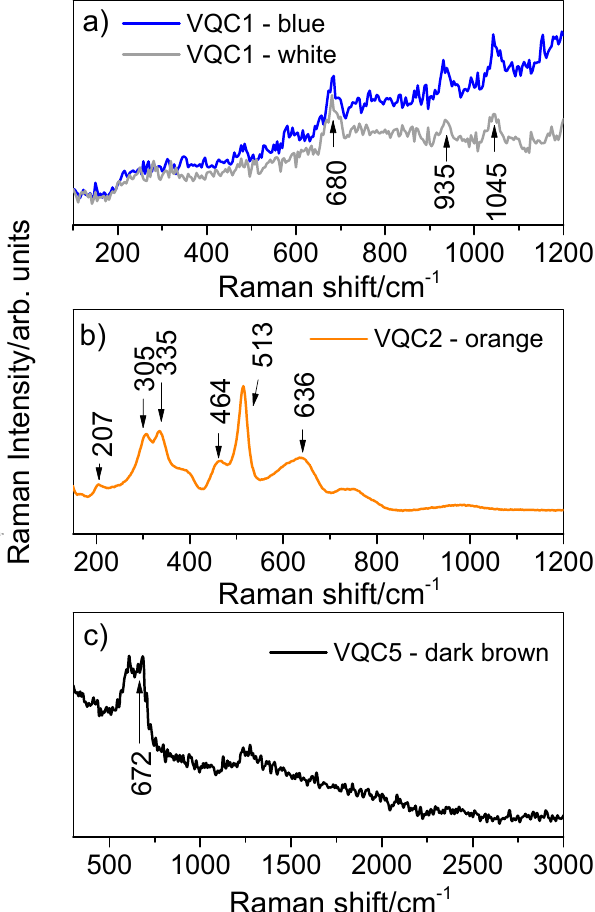
Figure 5. Representative Raman spectra recorded on ( a ) blue and white colouring areas of the VQC1 sample (excitation wavelength of 364 nm), ( b ) orange area of the VQC2 sample (excitation wavelength of 561 nm), and ( c ) dark-brown area of the VQC5 sample (excitation wavelength of 785 nm). It is worth